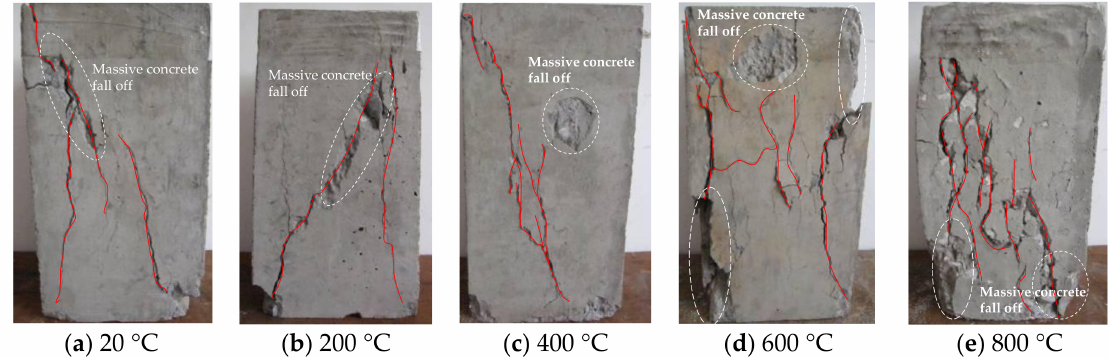
Figure 7. Typical failure mode of recycled aggregate concrete